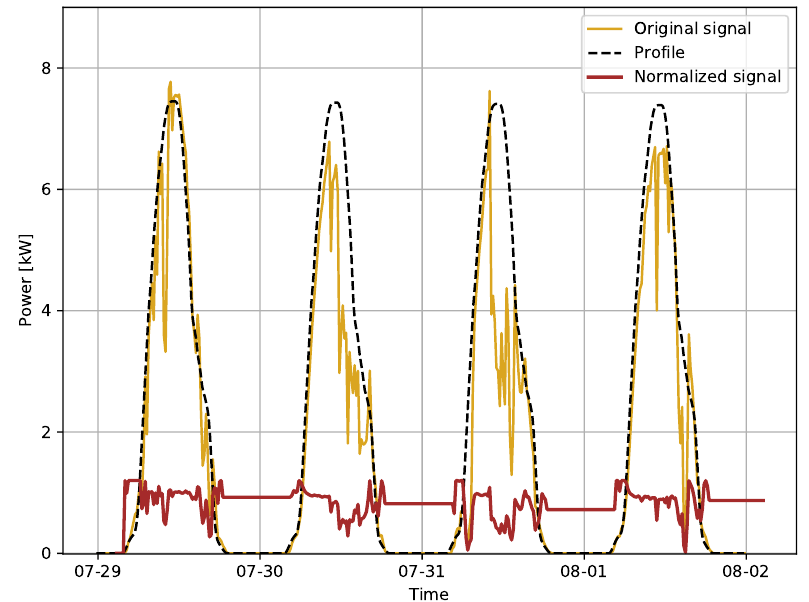
Figure 3. Example of normalization of the PV production signal at one site over four days: original signal (gold), clear sky profile (black, dashed) and normalized signal